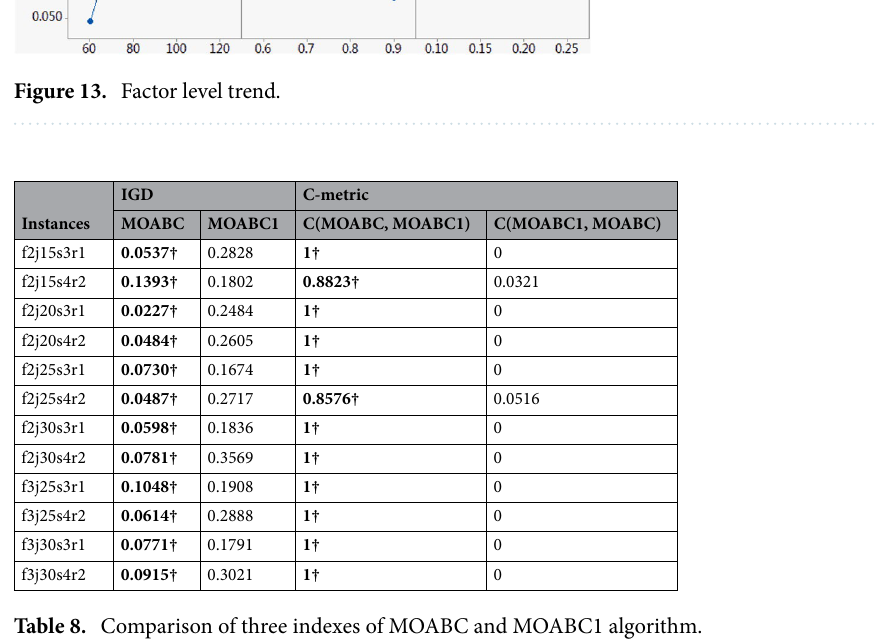
Table 8. Comparison of three indexes of MOABC and MOABC1 algorithm.